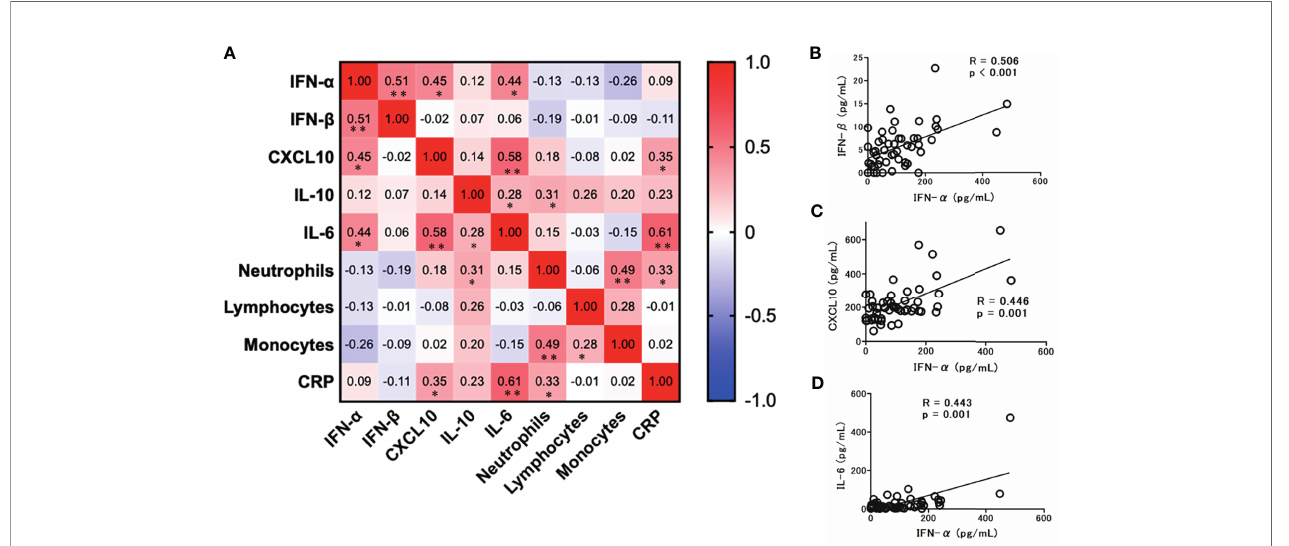
FIGURE 5 | Correlation matrix of immune parameters in patients with COVID-19 at admission (within 5 days after the onset of symptoms). (A) Results are presented as a correlation matrix. Spearman correlation coef fi cients are plotted. Cells were colored according to the strength and trend of correlations (shades of red = positive correlations; shades of blue = negative correlations). *p < 0.05. **p < 0.001. Signi fi cant correlations between serum IFN- a levels and IFN/cytokines; (B) IFN- b levels, (C) CXCL10 levels, and (D) IL-6 levels. Spearman correlation test was used, and Spearman correlation coef fi cient is shown. Corresponding logarithmic trendlines are